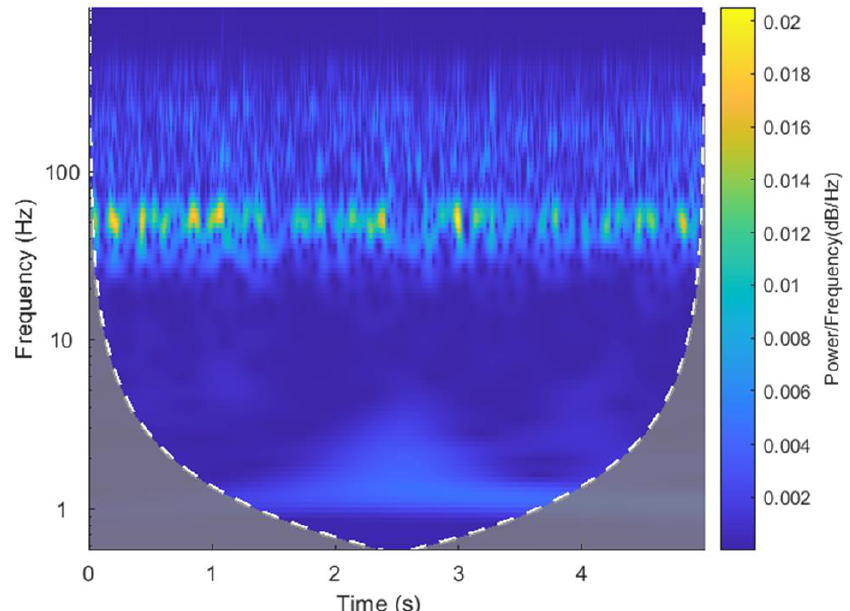
Figure 22. Wavelet-transformed time-frequency image of the predicted value from Channel 7 using frequency-domain data.